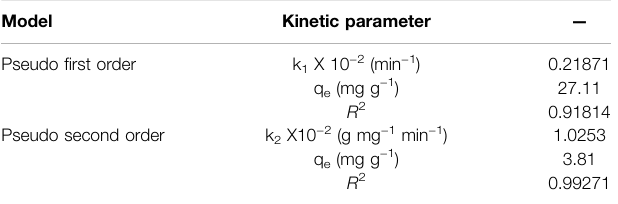
TABLE 1 | Kinetic parameters for the adsorption of malachite green over synthesized bionanocomposite. Model Kinetic parameter